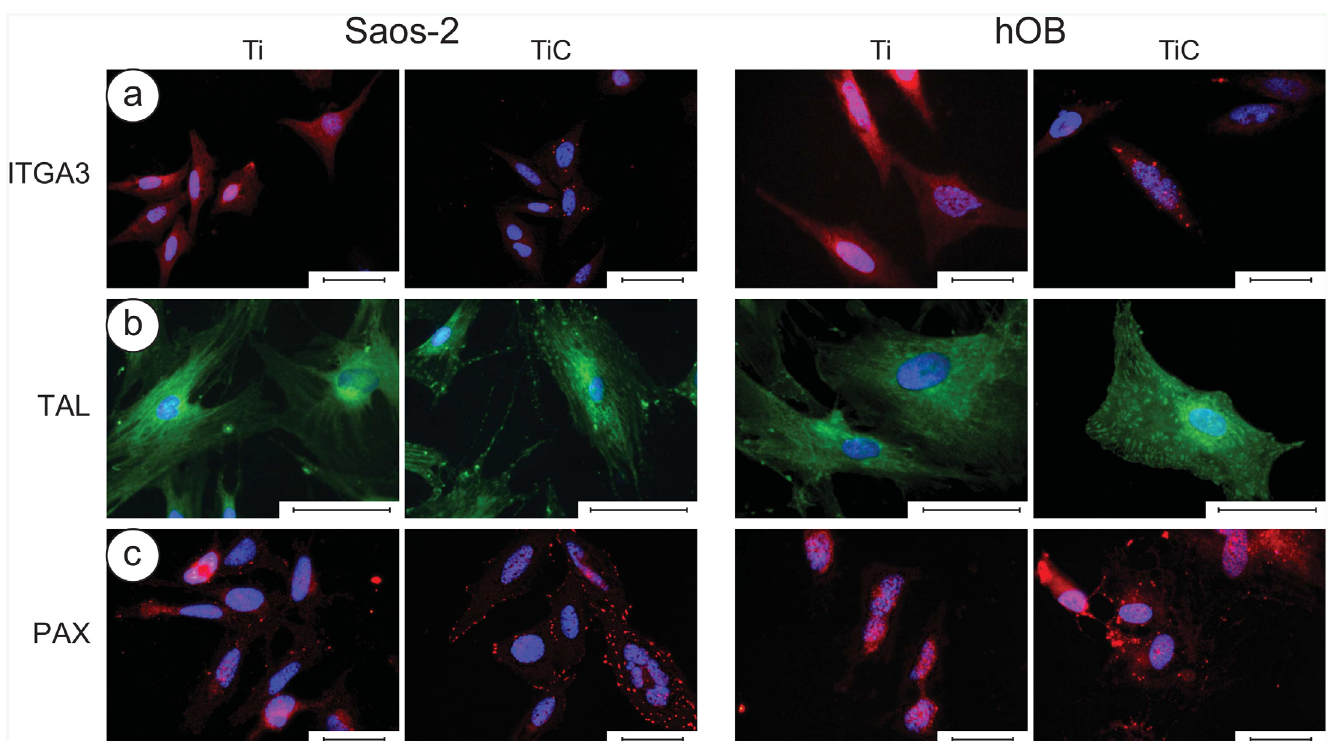
Fig 3. Immunofluorescence images of integrin α 3 β 1, talin and paxillin in Saos-2 cells and in human primary osteoblasts (hOB). Panel a: The Saos-2 (left panels) and the hOB cells (right panels) were grown for 96 h on glass slides coated with 10.5 nm of titanium or the nanostructured TiC layer, treated with primary monoclonal antibodies against integrin α 3 β 1 (10 μ g/ml). Panel b: The cells were treated with primary monoclonal antibodies against talin (10 μ g/mL). Panel c: Cells were treated with primary monoclonal antibodies against paxillin (10 μ g/ml). In all cases, the treatment was followed with Alexa Fluor 568 goat anti-mouse secondary antibodies, diluted 1:500 and the nuclei were stained with DAPI. The images were collected with a magnification of 63X for ITGA and PAX and of 100x for TAL, and the bar represents 100 μ m.